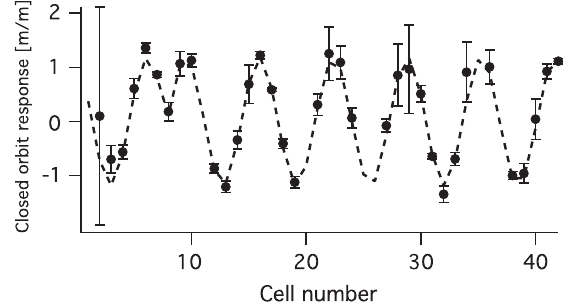
FIG. 7. Measurement of the response matrix generated by moving the D quadrupole horizontally in cell 8. The response is the difference of two closed orbits, measured with the quadrupole at (cid:4) 0 . 5 mm, divided by the magnet shift. The error bars are obtained by adding in quadrature the standard deviation of the shot-by-shot variation of the two closed orbits. The dashed line shows the fit after optimizing the parameters in Eq. (5). In this case, the momentum is 18 MeV =c , the optimization finds the tune is 6.52, the product of the betatron functions is 0 . 08 m 2 , and the phase difference between a D quadrupole and its neighboring BPM is 0.16 rad.